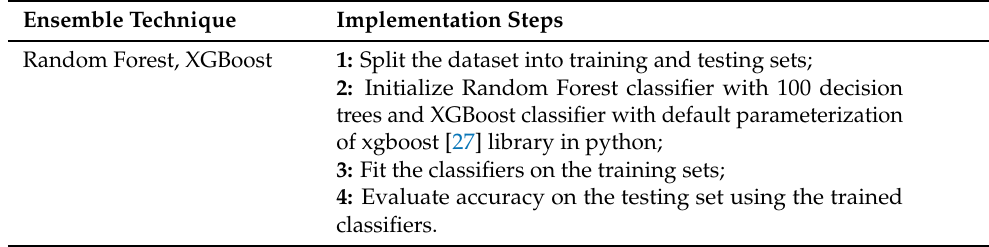
Table 6. Ensemble